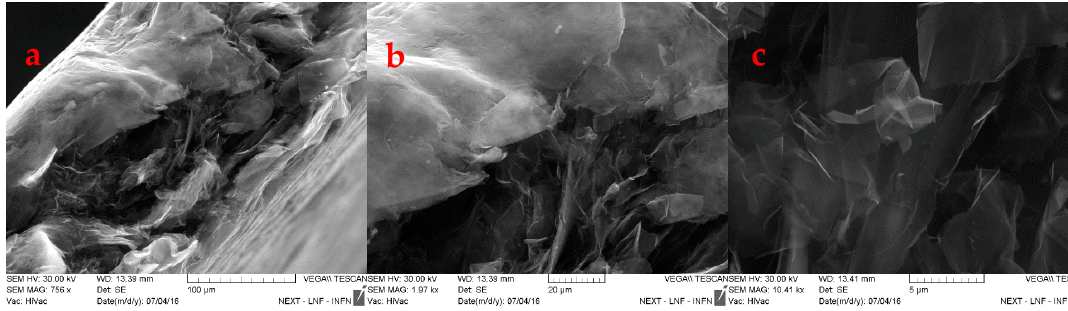
Figure 7. SEM images of sample 7 at different magnifications.